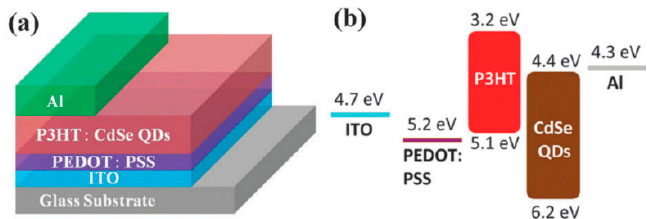
Figure 10. ( a ) A non-inverted structure of a BHJ solar cell composed of CP & QD; ( b ) the arrangement of energy levels of the materials used in the solar cell. Reproduced from [51] with permission of the Royal Society of Chemistry.